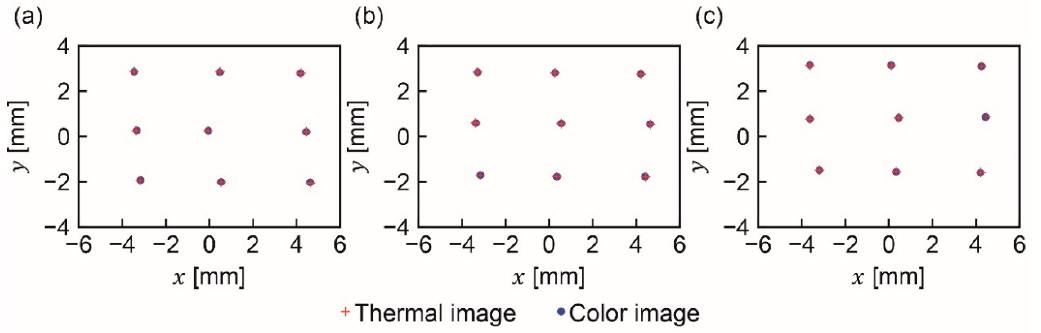
Figure A8. Positions of the light source at distances of ( a ) 0.5, ( b ) 1, and ( c ) 2 m on captured color images and mapped thermal images. The mapping was estimated using pairs of images of the light source at a distance of 2 m.